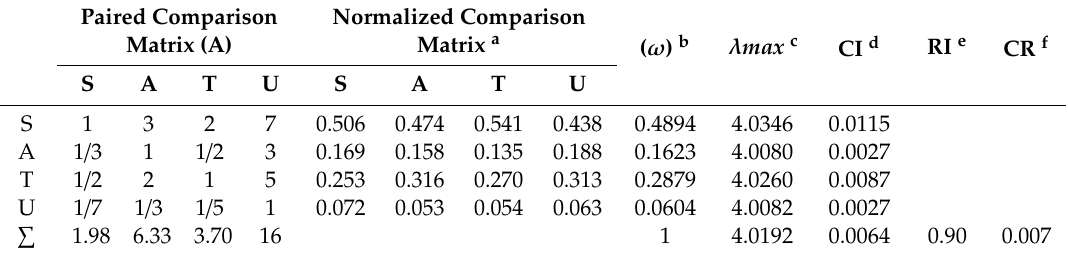
Table 4. Paired comparison matrix to evaluate the relative importance of the main criteria used to identify areas suitable for fish farming.